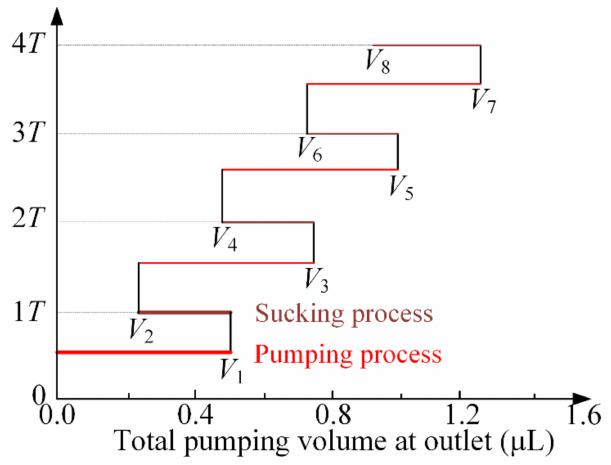
Figure 6. The total pumping volume at different